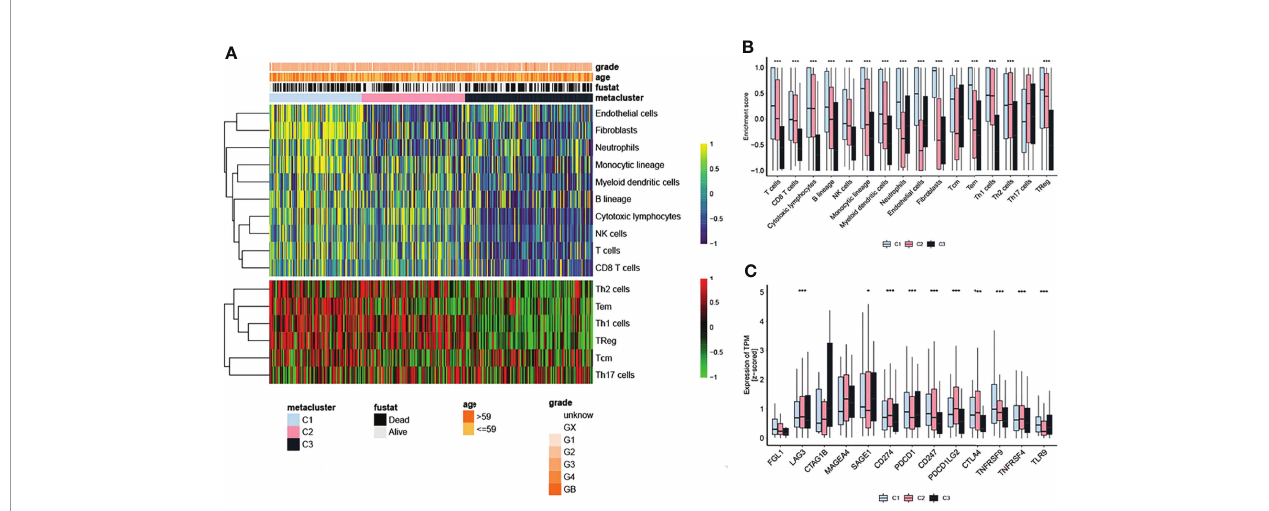
FIGURE 3 | Immune checkpoints in OV subtypes. (A) Heatmap showing the level of immune in fi ltration in the different subtypes. (B) Differences in the enrichment score of in fi ltrated immune cells among the three subtypes. (C) Expression of immune checkpoint genes among the three subtypes. The statistical difference was compared through the Kruskal – Wallis test, and the P values are labeled above each boxplot with asterisks ( *P < 0.05, **P < 0.01, ***P <